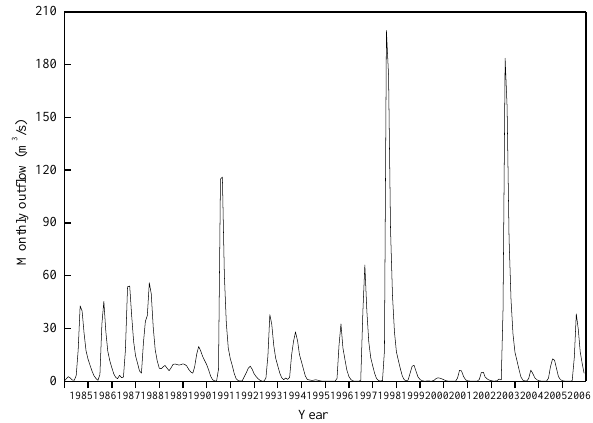
Fig. 8. Simulated monthly outflow in the Zhalong Wetland, Northeast China, during 1985-2006.